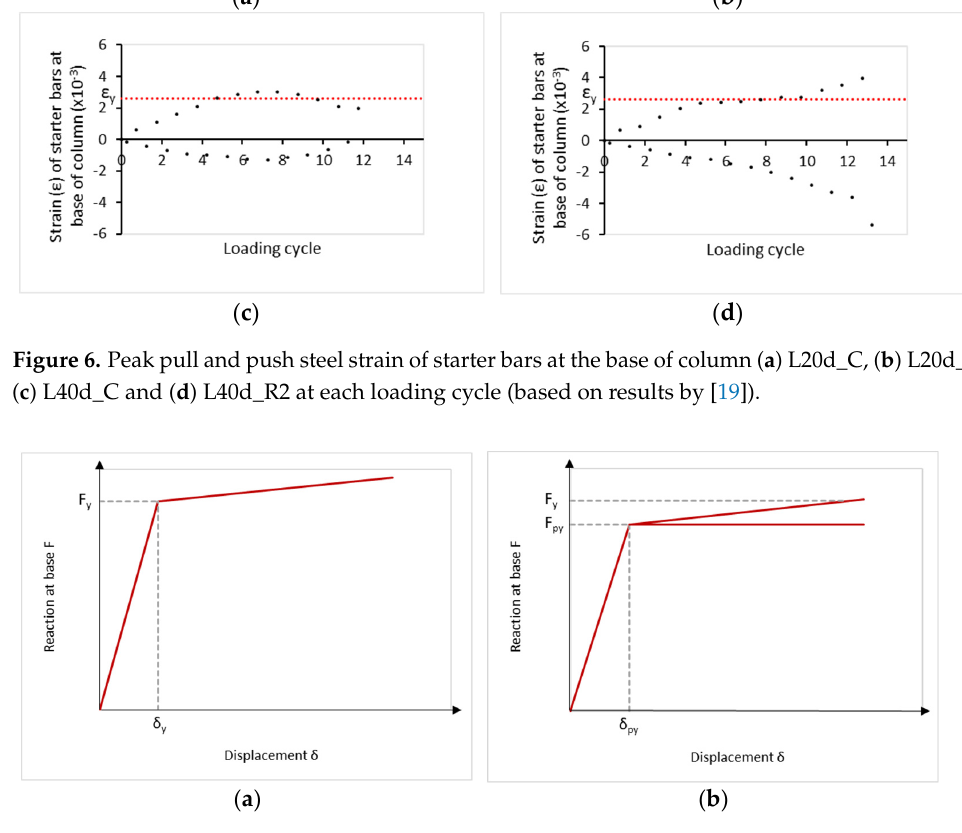
Figure 8. ( a ) Strain gauges layout. ( b ) Expected strain distribution along lap-spliced bars (based on